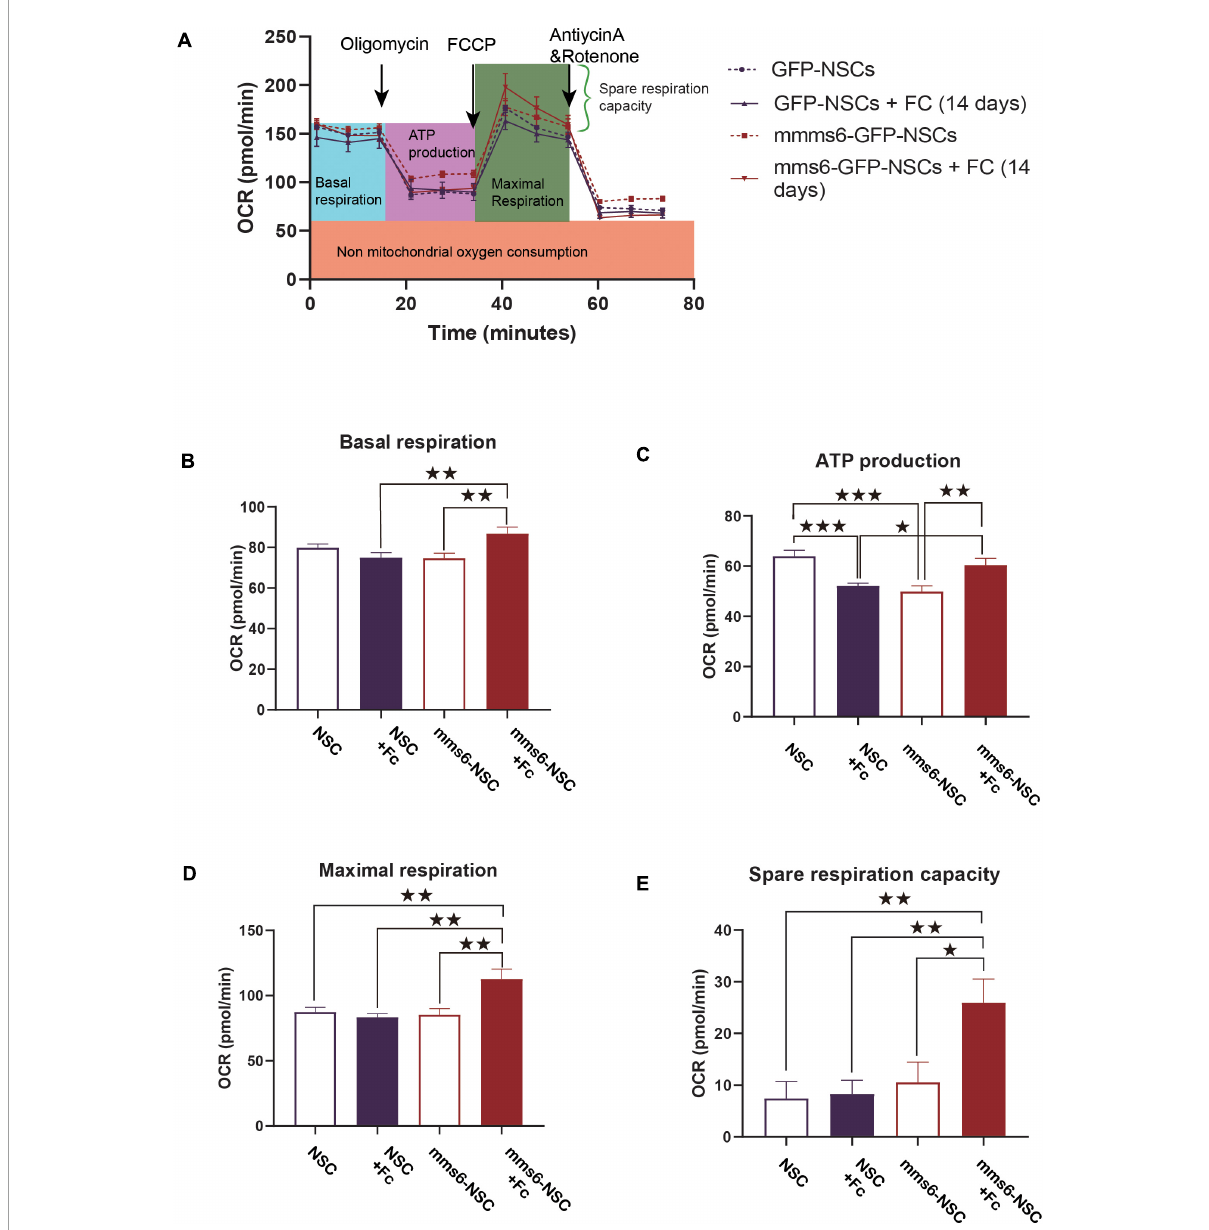
FIGURE2 The expression of mms6 helps stem cells resist the effect of iron overloading on mitochondrial respiratory functions. (A) Schematic diagram of the detection process of the oxygen consumption of cells in different groups; (B) basic oxygen consumption: the addition of exogenous iron increased the basal respiration capability of mms6-GFP-NSCs but not GFP-NSCs; (C) oxygen consumption during ATP production: the addition of exogenous iron decreased the ATP production of NSCs but increased it in mms6 -GFP-NSCs; (D) the addition of exogenous iron enhanced the maximal oxygen consumption of mms6 -GFP-NSCs but not that of the control group; and (E) the addition of exogenous iron obviously enhanced the spare oxygen consumption capacity of mms6 -GFP-NSCs but not that of the control group. * indicates a P -value < 0.05; ** < 0.01; and *** <